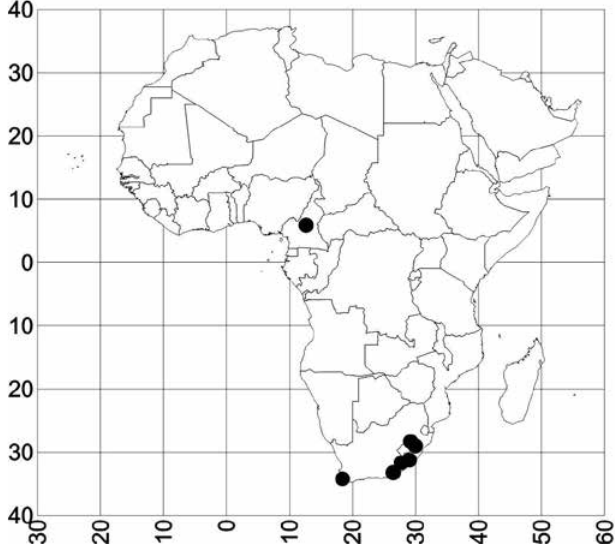
Map 9 . The distribution of B. pumicosa